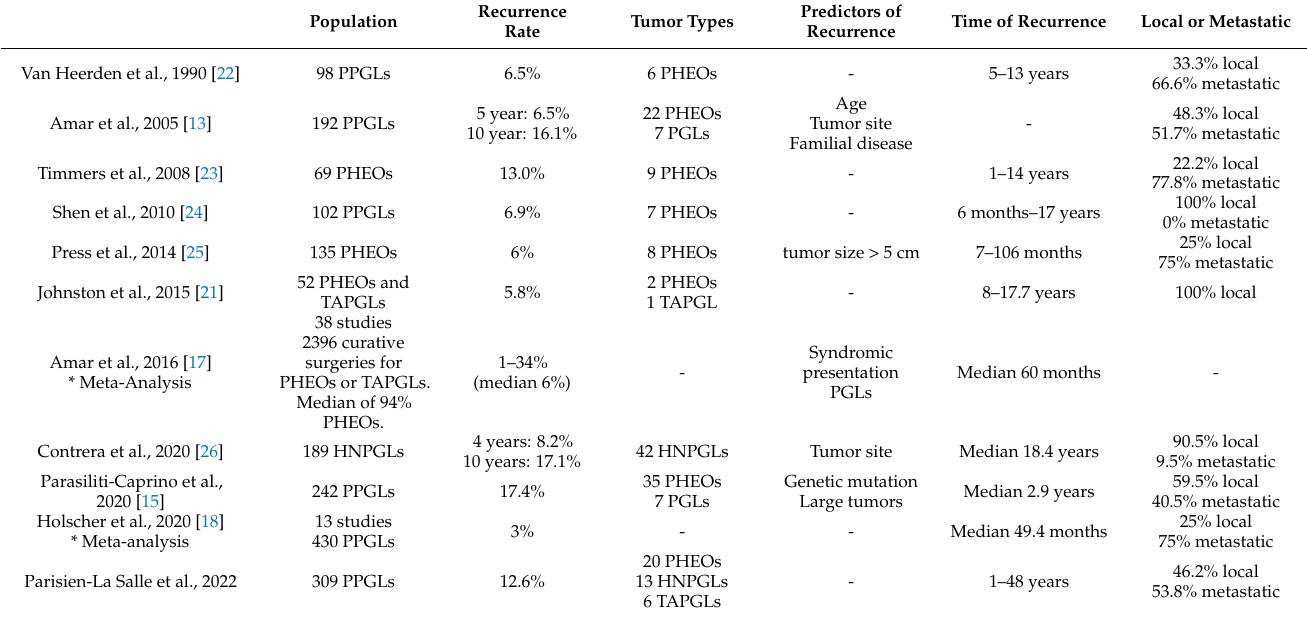
Table 3. Overview of recurrence rate for PHEOs and PGLs reported in the literature. Population Tumor